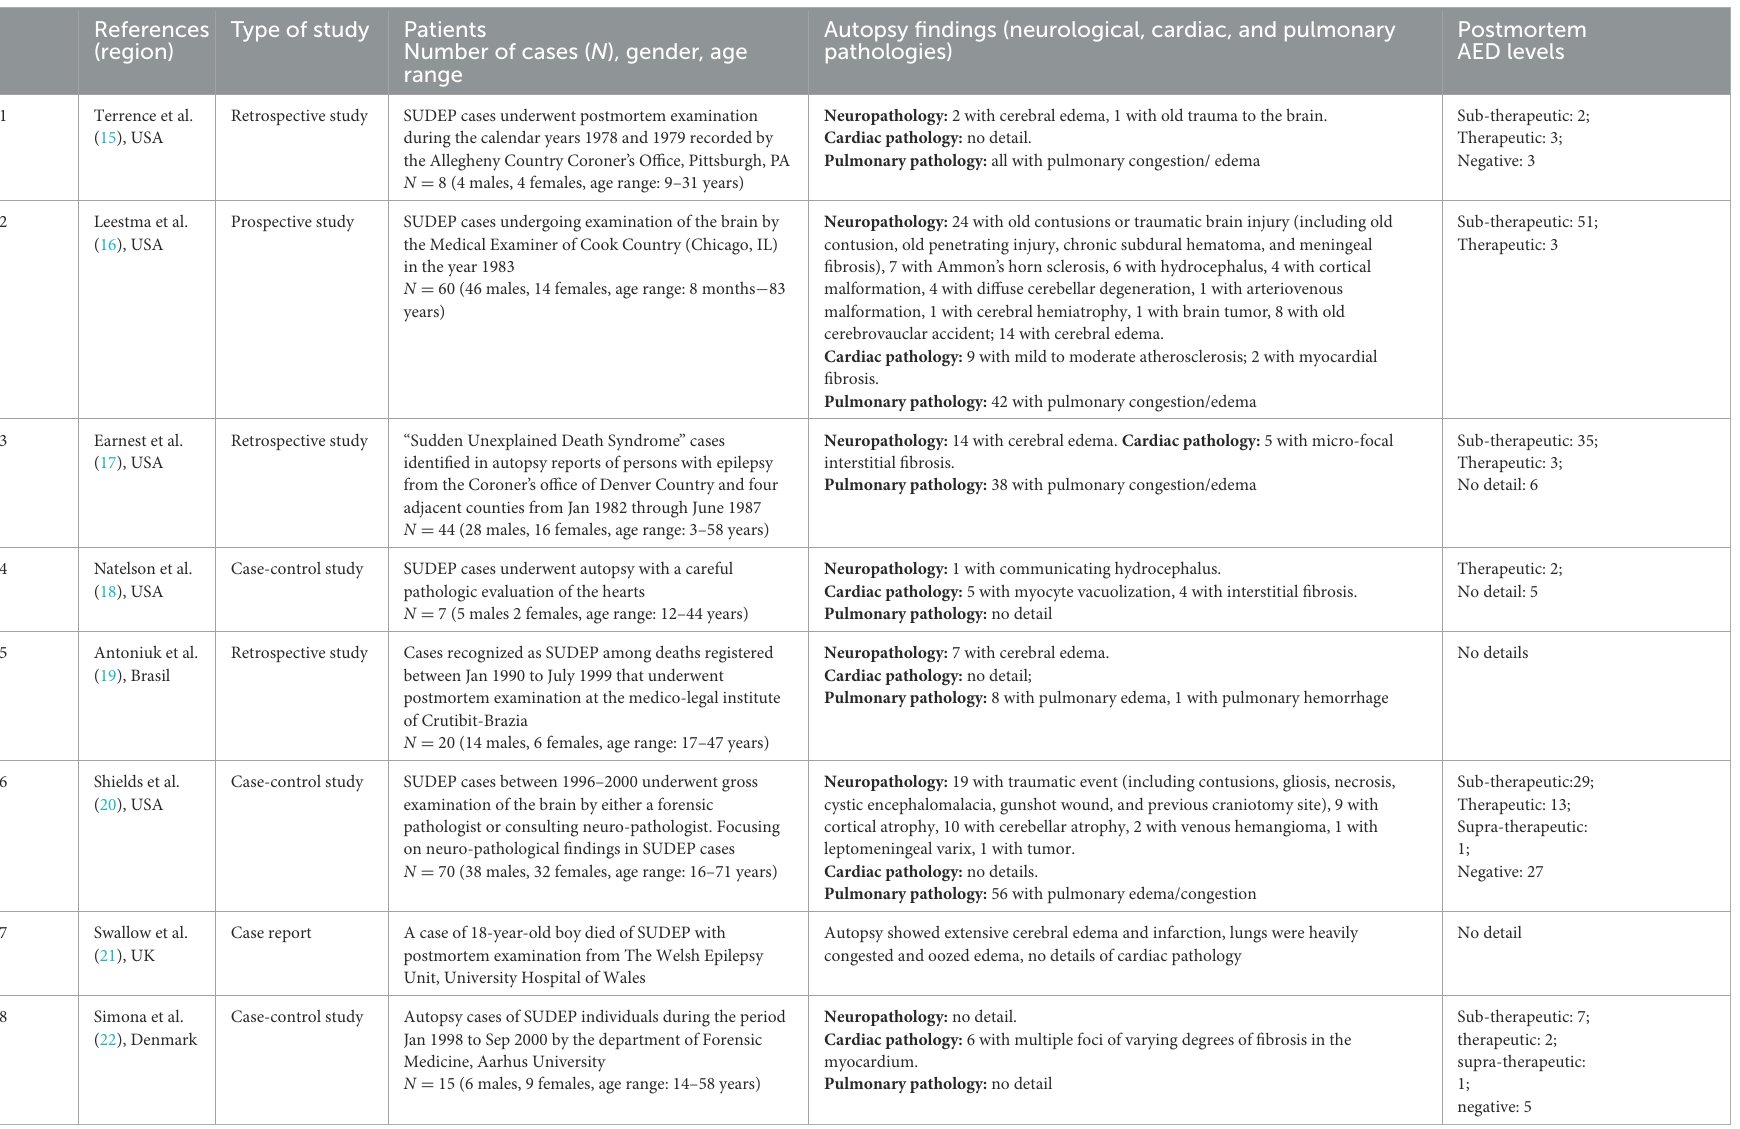
TABLE 2 Summary of the postmortem findings from the autopsy study